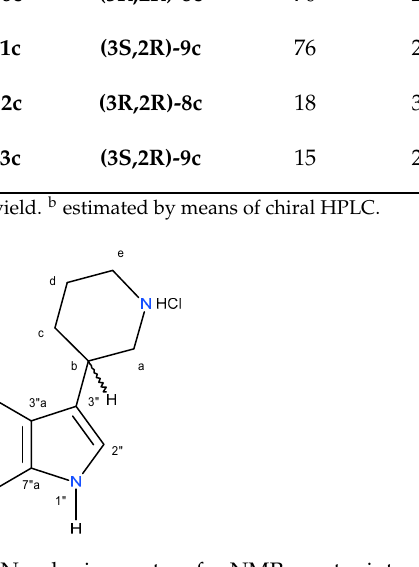
Figure 9. Numbering system for NMR spectra interpretation of compounds (R)-10a-c and (S)-11a-c. Table 3. Data on chiral (R) and (S) 3-(piperidin-3-yl)-1H-indol derivatives (R) - 10a-c , (S) - 11a-c and